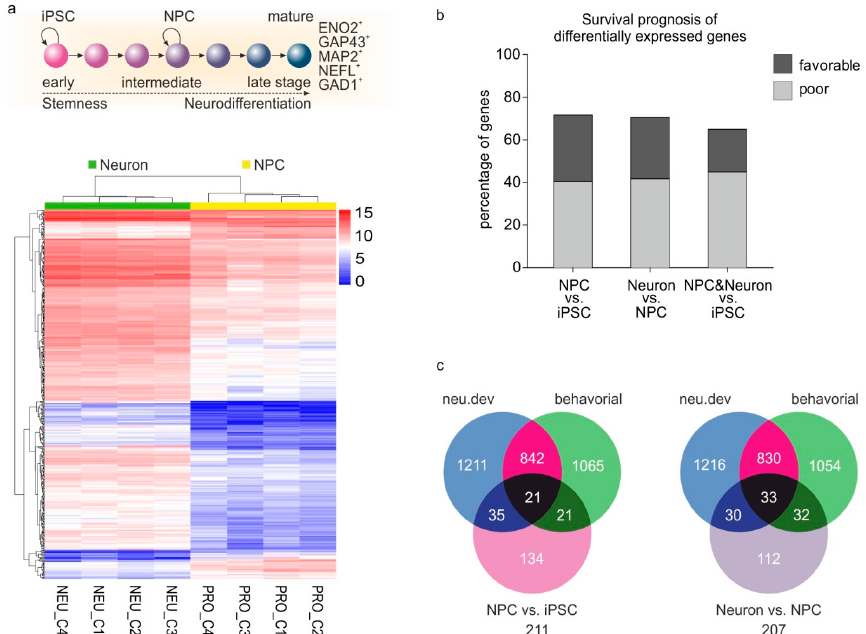
Figure 4. Genes involved in early and late stages of neuronal differentiation are co-opted during cancer progression. ( a ) Top: Scheme of differentiation from iPSCs to NPC and mature neurons. Markers of mature neurons which were used for the differential gene expression analysis are indicated. Bottom: Representative heatmap of differential gene expression in neurons versus NPCs for the study GSE135287. ( b ) Percentage of the differentially expressed genes between the indicated states of differentiation that have poor or favorable prognosis on patient outcomes in PanCancer. ( c ) Venn diagrams showing the overlaps of neu.dev and behavioral factors with the differentially expressed genes in NPC versus iPSC (left) and Neuron versus NPC (right). iPSC: induced pluripotent stem cell; NPC: neural progenitor cell.